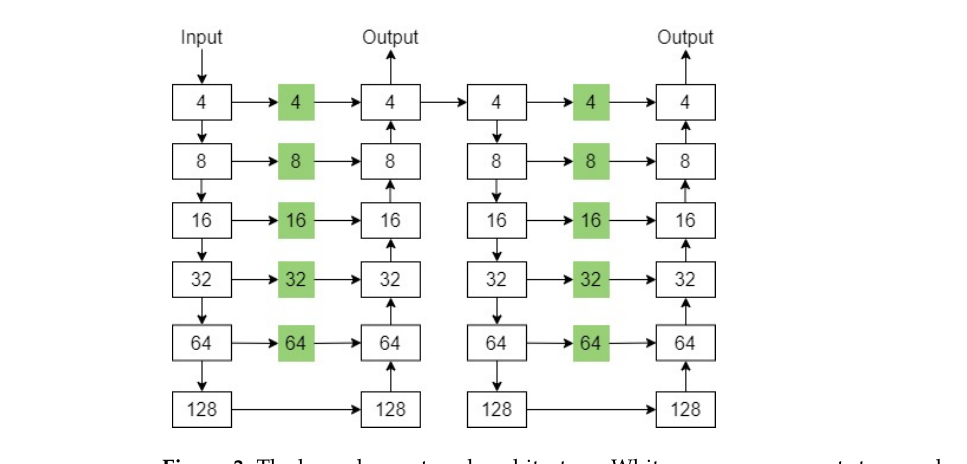
Figure 3. The hourglass network architecture. White squares represent stage nodes and green squares represent sum nodes.